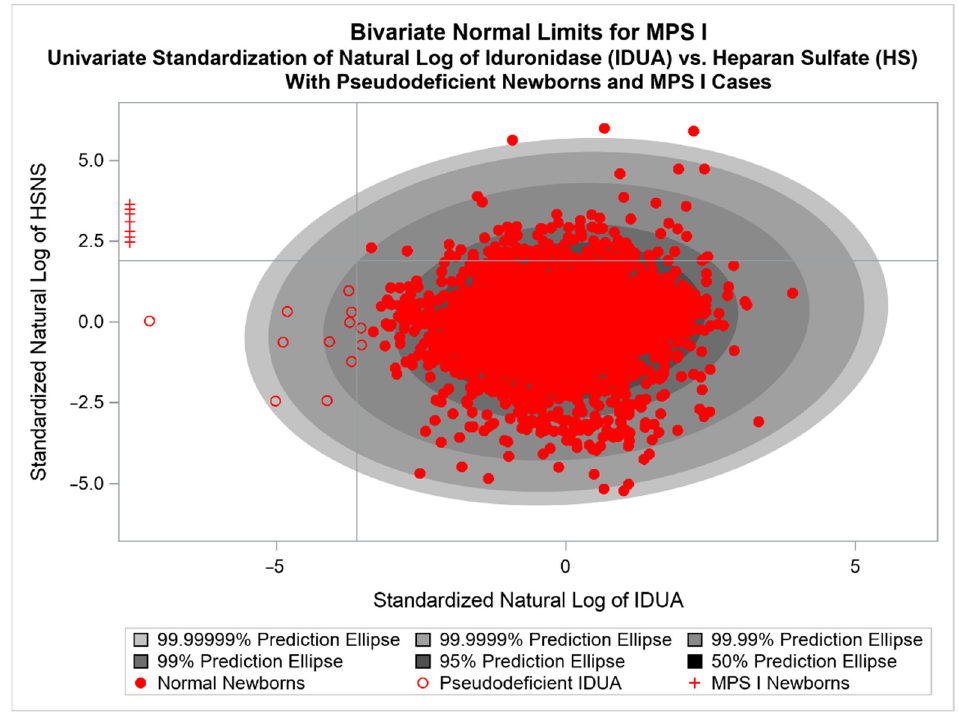
Figure 2. BVNL estimated from Gifu Normative Sample (open and filled red circles; N = 5000) based on alpha ‐ L ‐ iduronidase (IDUA) and Heparan Sulfate (HS) level. All MPS I newborns (red plus signs, N = 7) and 12 pseudo ‐ deficient cases (open red circles, N = 12) are correctly identified.